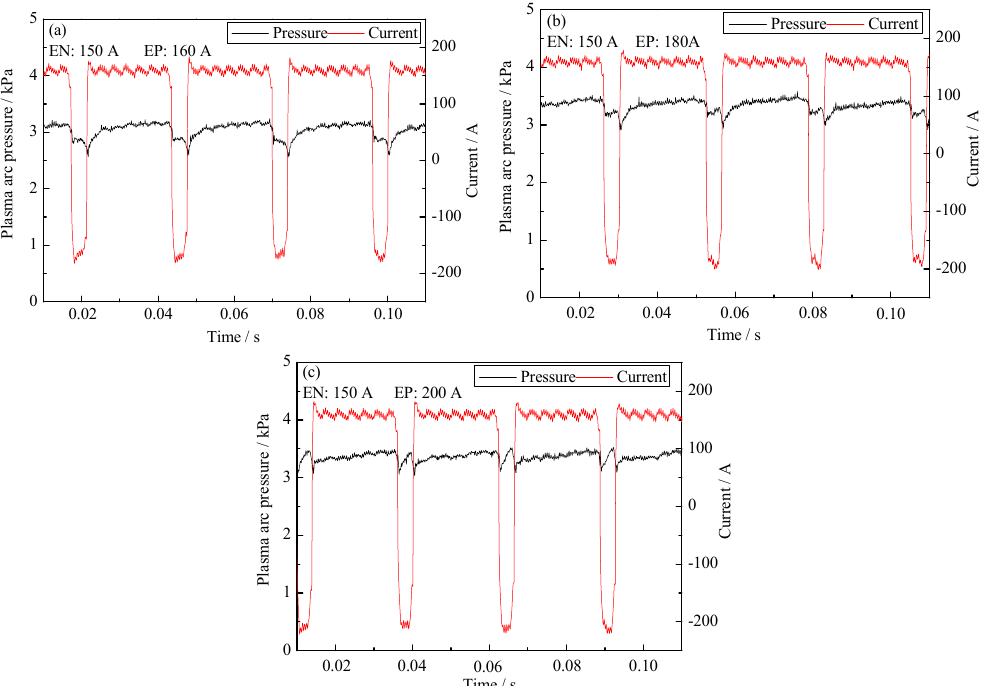
Figure 15. The plasma arc pressure and current waveform with different current of EP phase. ( a ) 150 A in EN phase and 160 A in EP phase; ( b ) 150 A in EN phase and 180 A in EP phase; ( c ) 150 A in EN phase and 200 A in EP phase.